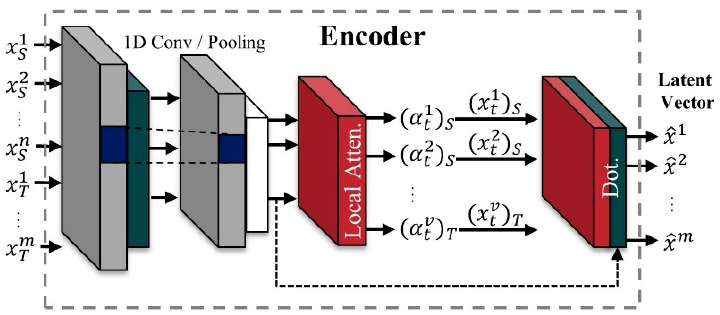
Figure 6. Attention mechanism-based encoding module.